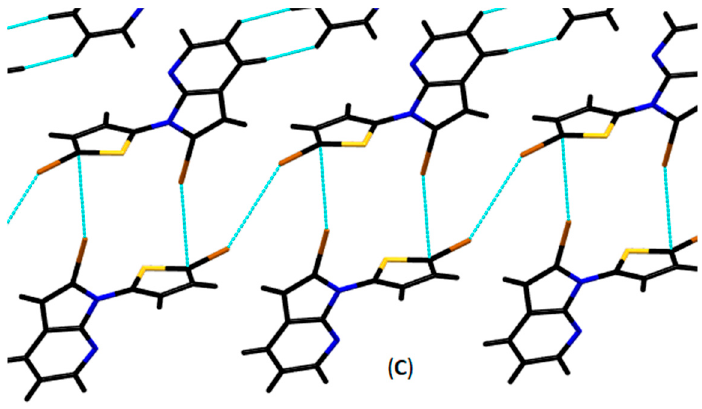
Figure 8. Halogen and chalcogen bond networks observed for 3a ′ ( A ) and 3g ( B ), respectively; short contact involving iodine atoms for 3g ′ ( C ).